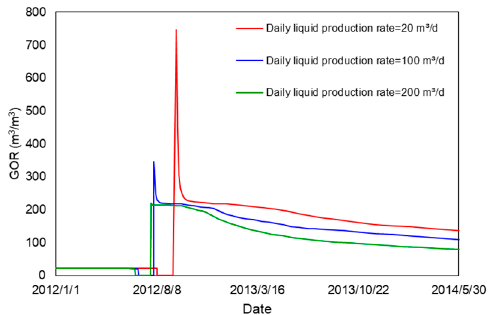
Figure 29. Production GOR of well